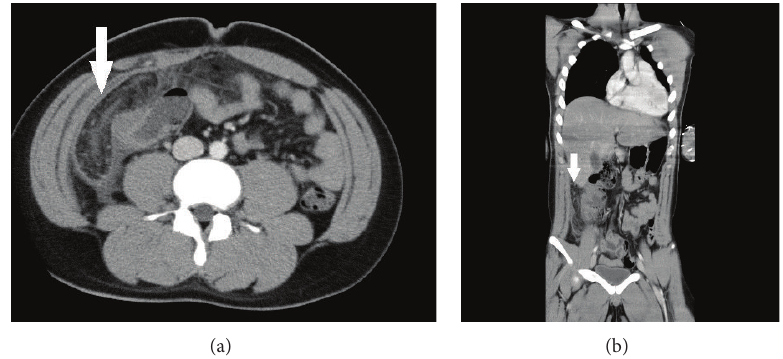
Figure 1: Contrast-enhanced abdominal CT. (a) The fat density of the greater omentum has increased (arrow), a finding that is compatible with a diagnosis of omental infarction. (b) The greater omentum has moved into the right paracolic gutters. A small amount of peritoneal fluid is detected around the omentum.